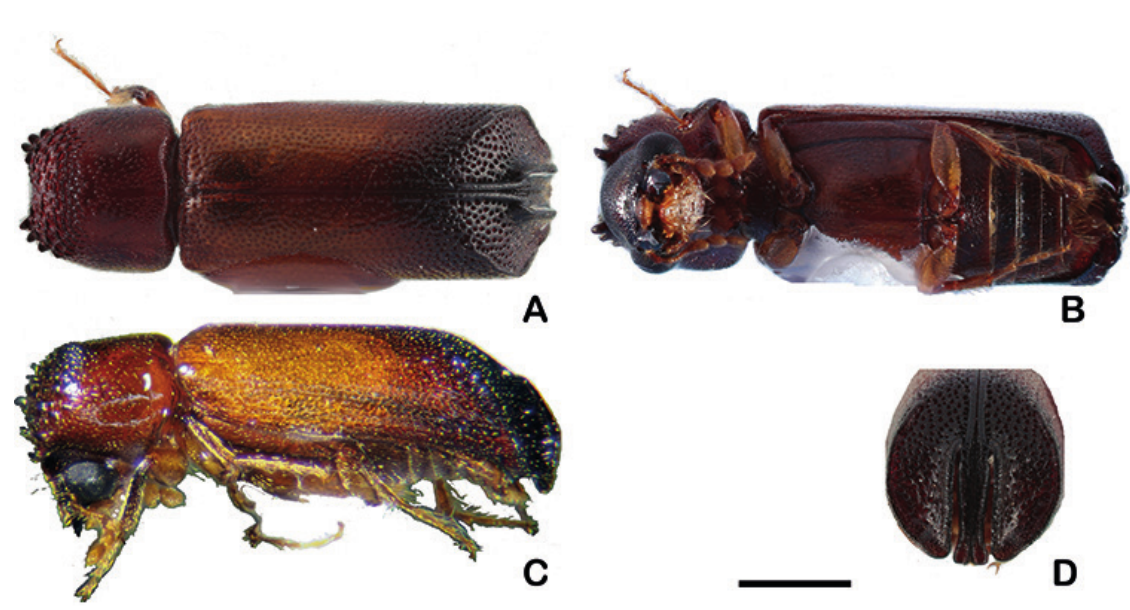
Fig. 3. Infrantenna fissilis gen. et sp. nov., ♀, allotype (NHMUK014433956). A . Dorsal view. B . Ventral view. C . Lateral view. D . Declivity. Scale bar = 1 mm.